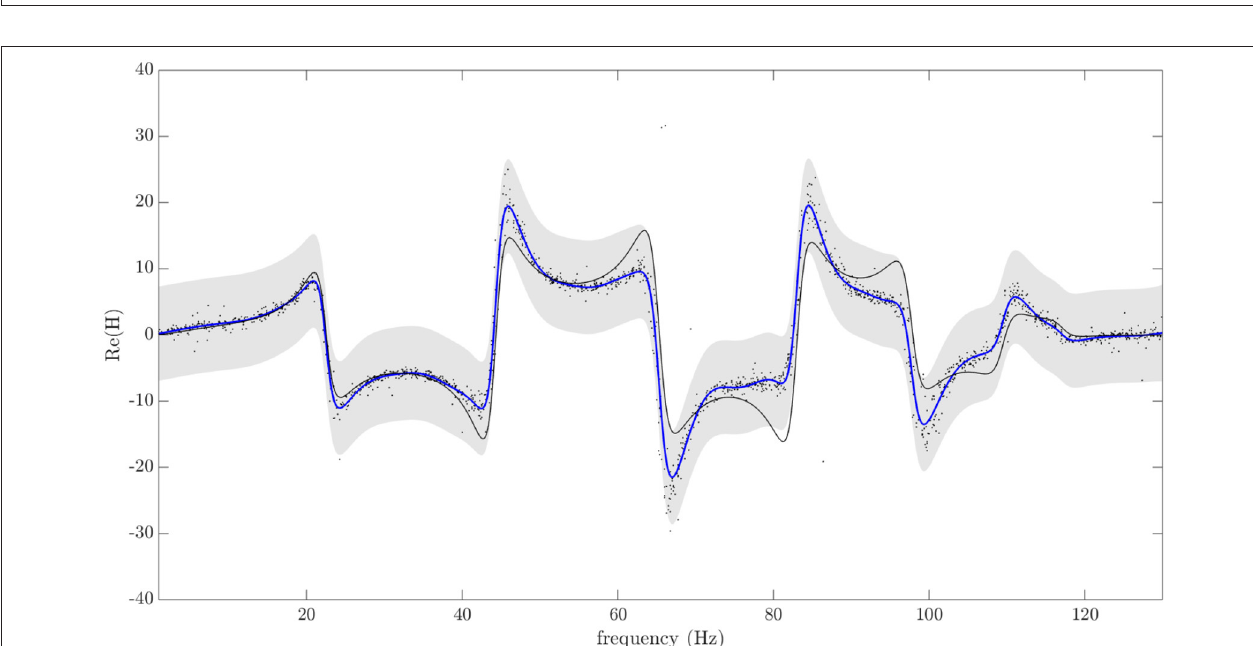
FIGURE 4 | Gaussian process regression of the FRF as the population-form. Black markers indicate the training-set. The blue line indicates the posterior predictive mean and the shaded area indicates a 3- σ credible region, corresponding to the variance. The black line plots the mean function of the GP prior.